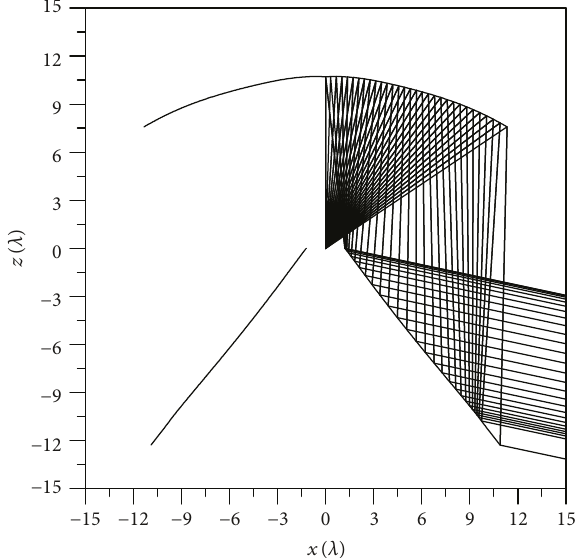
Figure 15: Generatrices and ray tracing of the shaped ADC antenna ( − 30 dB attenuation at x